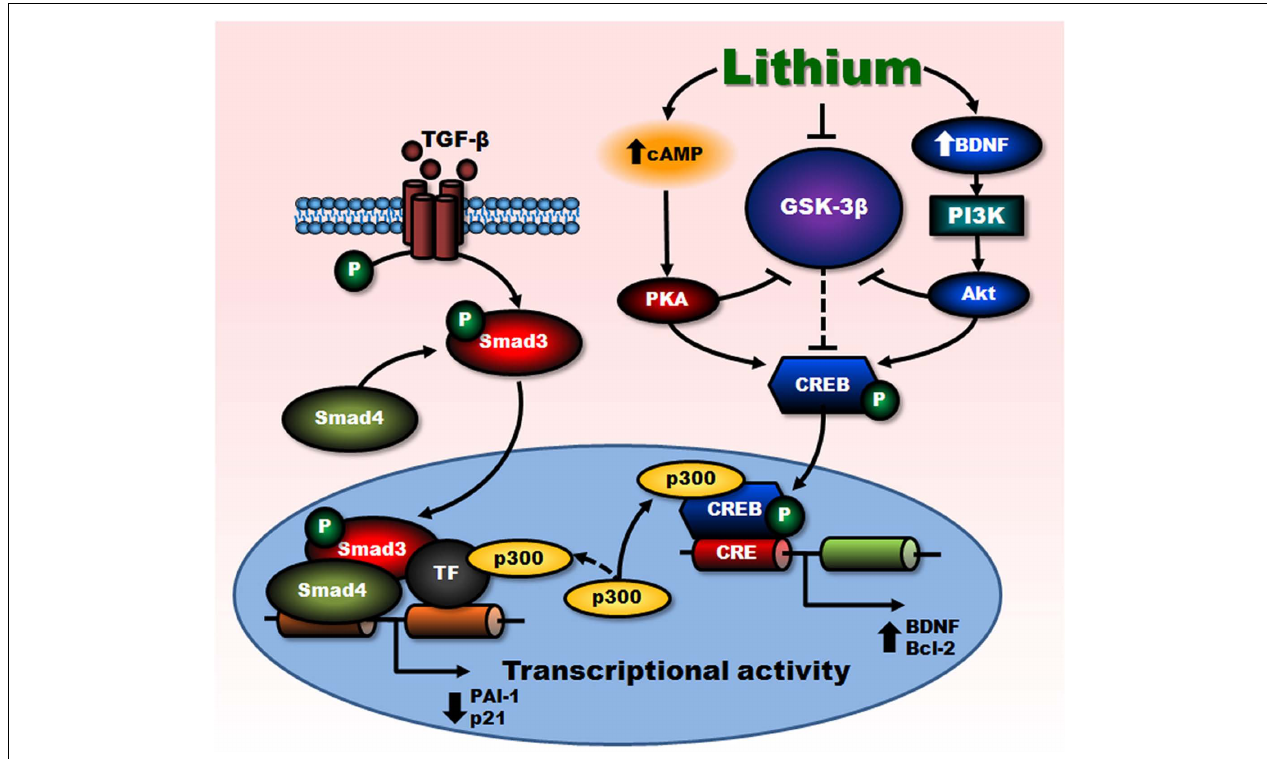
such as BDNF and Bcl-2. Enhanced gene transcription triggered by BDNF, via sequestration of transcriptional co-activator p300, suppresses Smad3/4-dependent transactivation and subsequently decreases the expression ofTGF- β -responsive genes, PAI-1, and p21. Lines with solid arrows represent stimulatory connections; lines with flattened ends represent inhibitory connections. Dashed lines represent pathways with reduced activity as a result of lithium treatment. CRE, cAMP response element. (Modified from Liang et al.,